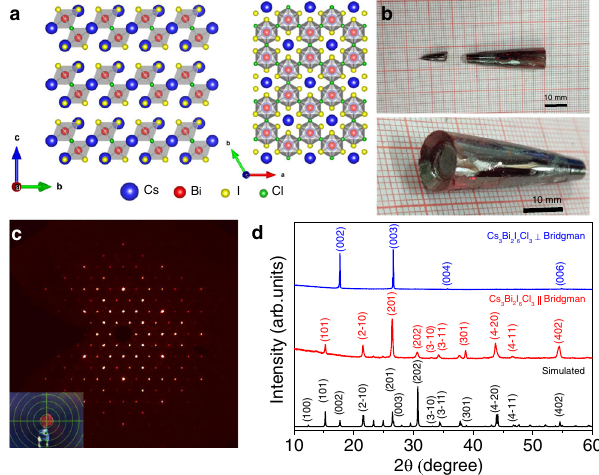
Fig. 1 | Crystal structure of Cs 3 Bi 2 I 6 Cl 3 . a Crystal structure of the 〈 111 〉 oriented layered halide perovskite Cs 3 Bi 2 I 6 Cl 3 . b Optical photographs of the Bridgman grown Cs 3 Bi 2 I 6 Cl 3 single crystal. c Laue diffraction spots (along c direction) from the Cs 3 Bi 2 I 6 Cl 3 single crystal. Inset shows photograph of a broken piece of single crystalspecimenmountedonthesampleholder. d RoomtemperatureXRDpattern of Cs 3 Bi 2 I 6 Cl 3 single crystal cut along parallel (||) and perpendicular ( ⊥ ) to the Bridgman growth